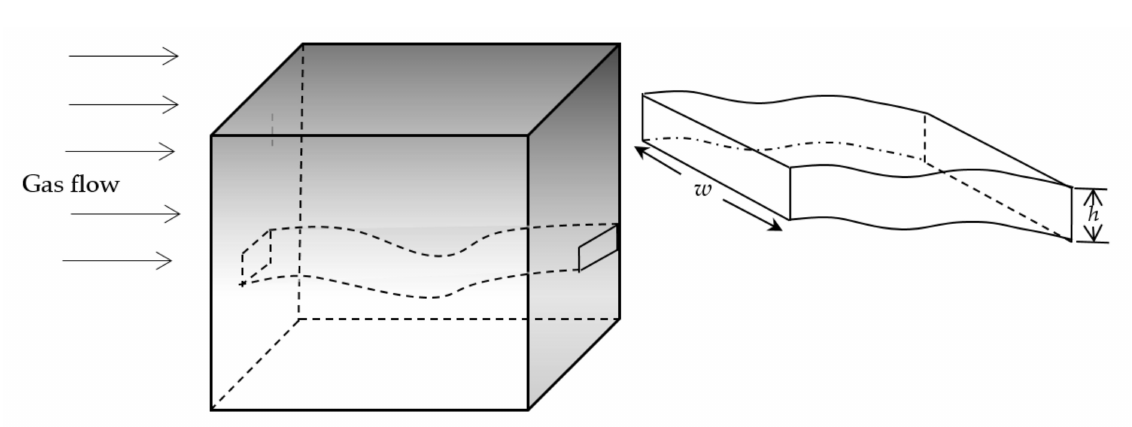
Figure 1. A schematic diagram of tight reservoir rocks composed of a bunch of parallel